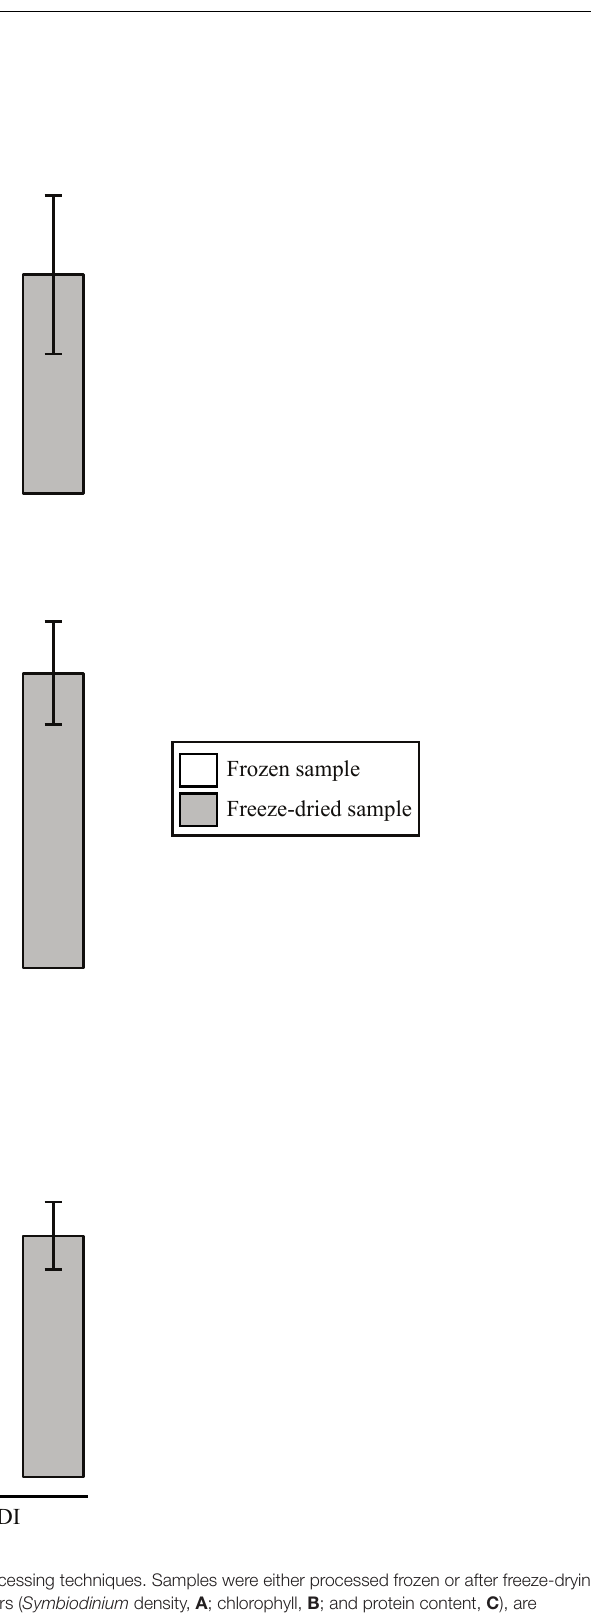
Frontiers in Marine Science |